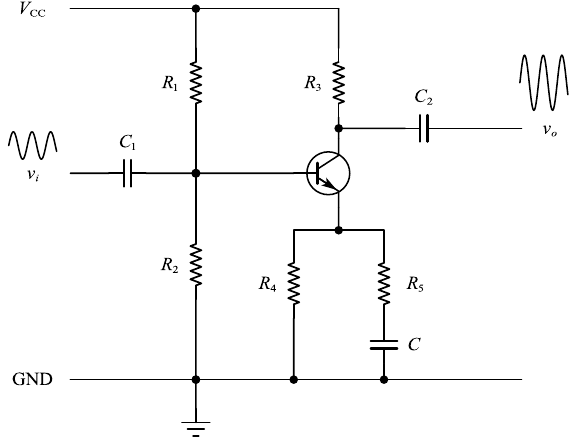
Figure 4. First-order active equalization circuit